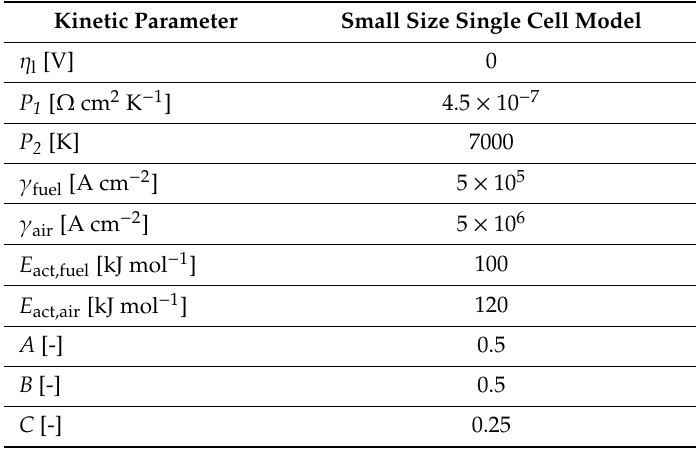
Table 2. Kinetics parameters for a small-sized single